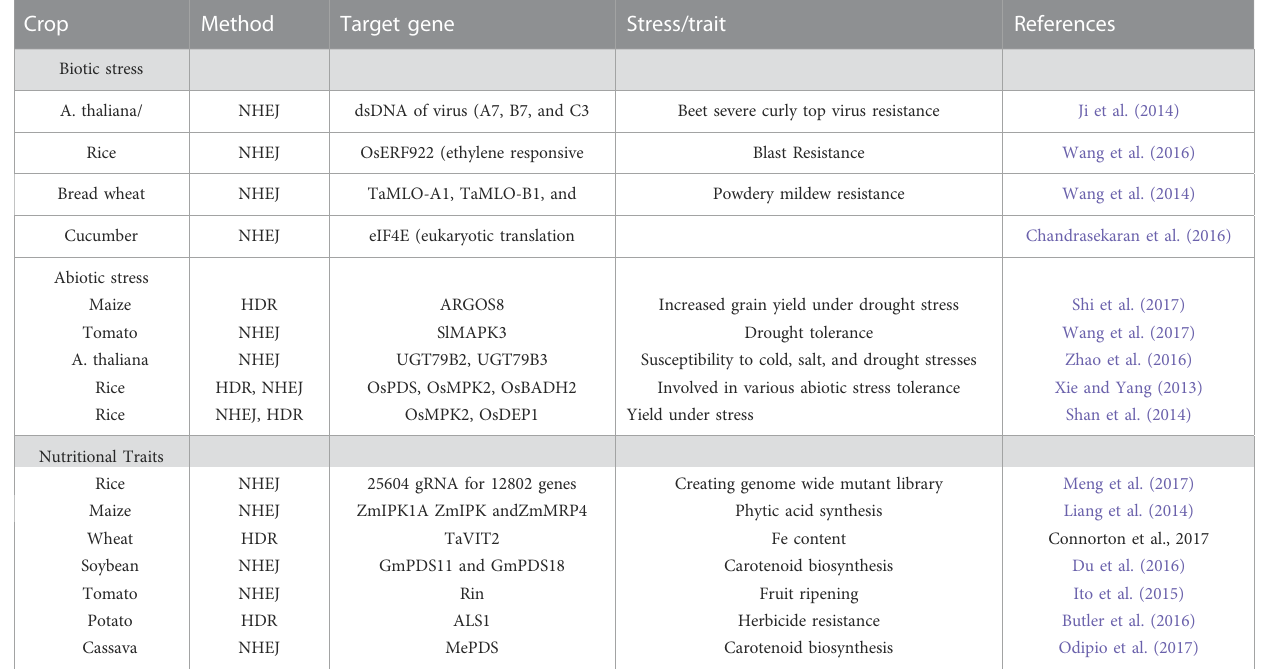
TABLE 2 Application of CRISPR based genome editing approach in plants for biotic, abiotic, and nutritional